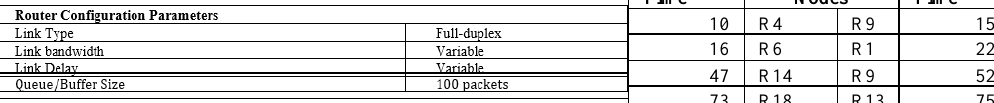
Table 2: Routers Configuration Parameter